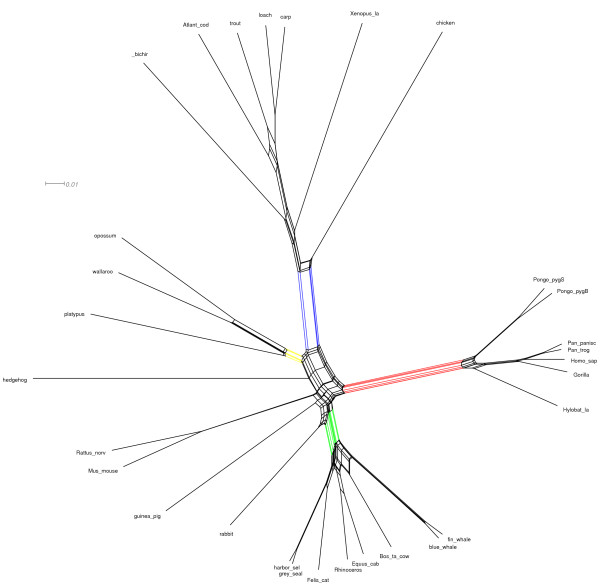
The MC-Net network for the Mammal data set.